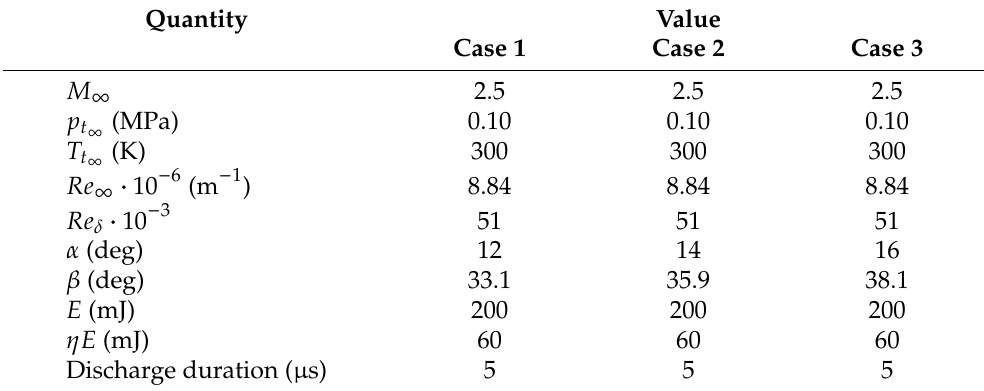
Table 19. Flow Conditions.